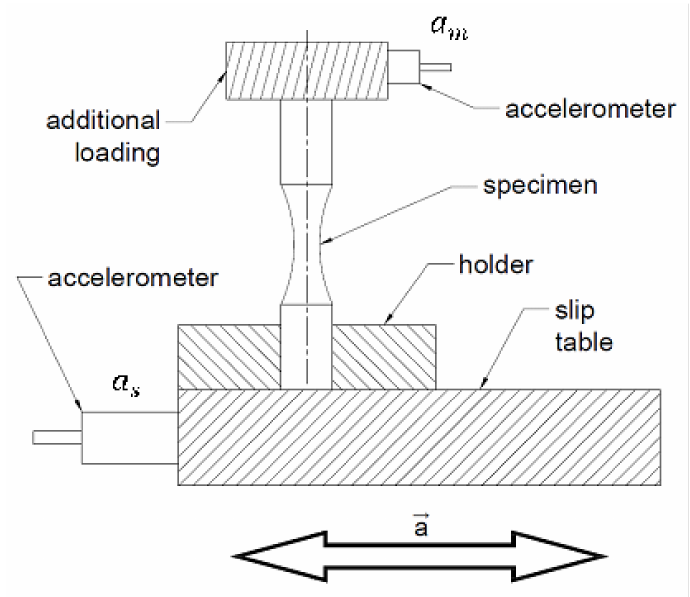
Figure 4. Fatigue test stand configuration with additional